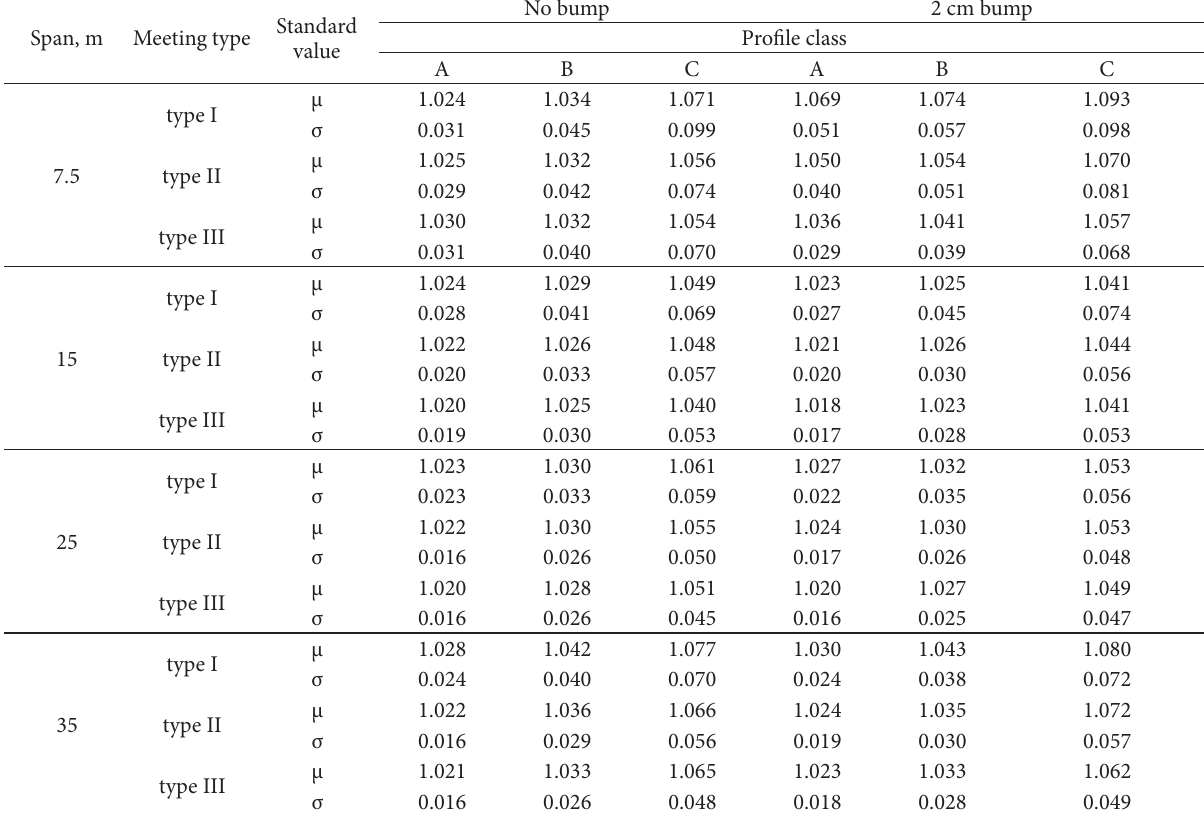
Table 6. Mean (μ) and standard deviation (σ) for DAF results from Monte Carlo simulation of meeting events Span, m Meeting type